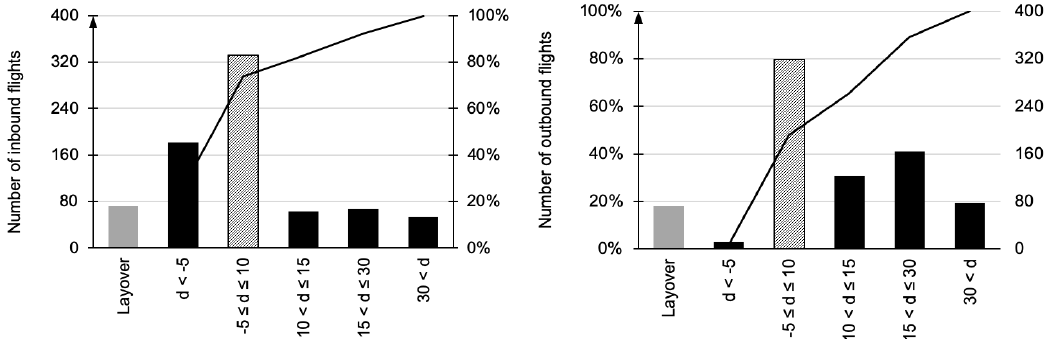
Figure 1. Frequencies of inbound delay d (minutes) ( left ) and outbound delay ( right ) of the example 24-h rotation schedule on Frankfurt airport (FRA) from 22 July 2017. Despite a 75% share of punctual inbound flights, only 50% of outbound flights were on